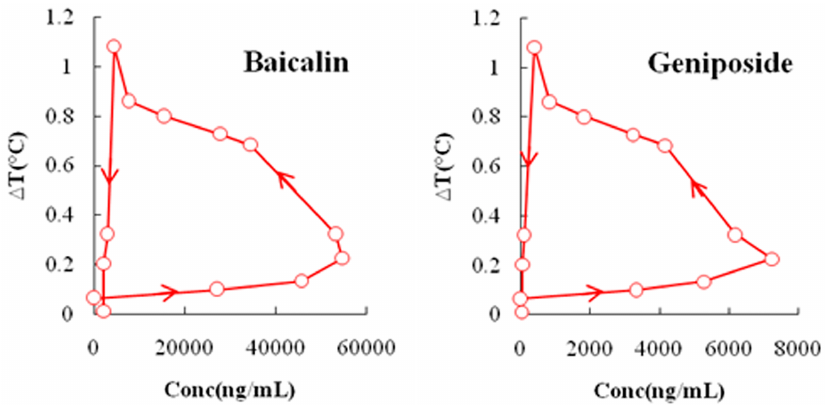
Figure 4. Anticlockwise hysteresis loop indicating equilibration delay between the effect (rectal temperature change) and the plasma concentrations of baicalin and geniposide.